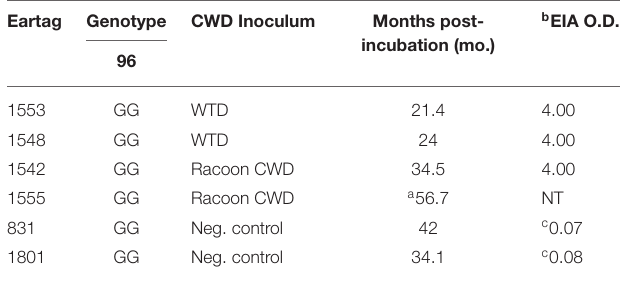
TABLE 1 | Animal experimental summary of genotype, inoculum, survival period, and enzyme-immunoassay (EIA) in white-tailed deer inoculated oronasally with the agent of chronic wasting disease from white-tailed deer and racoon. Eartag Genotype CWD Inoculum Months post- incubation